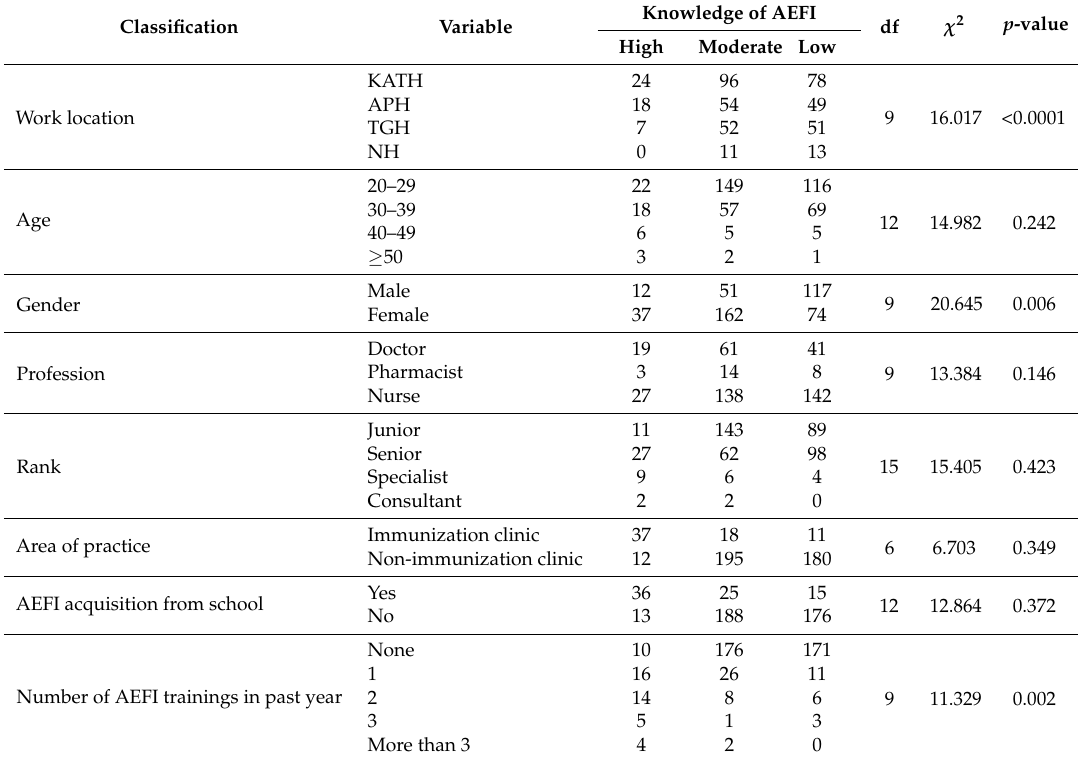
Table 5. Tests of association between AEFI knowledge and study participant